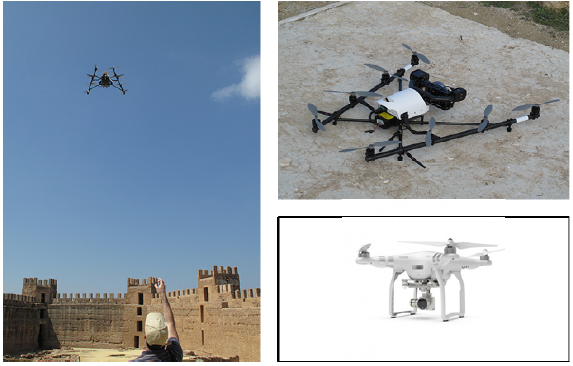
Figure 4. UAS used in this work. Left and upper right: AscTec Falcon 8. Lower right: Phantom DJ 3 Advanced.